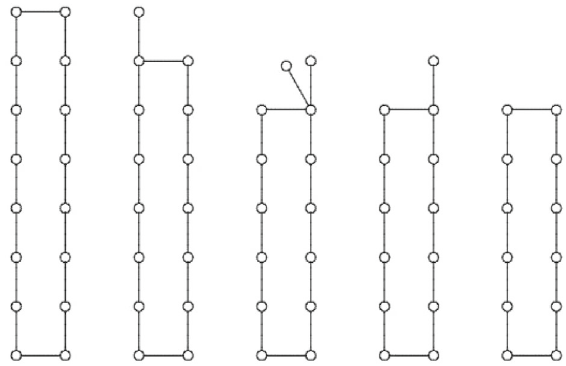
Fig. 4 A uniform 4-folding of C